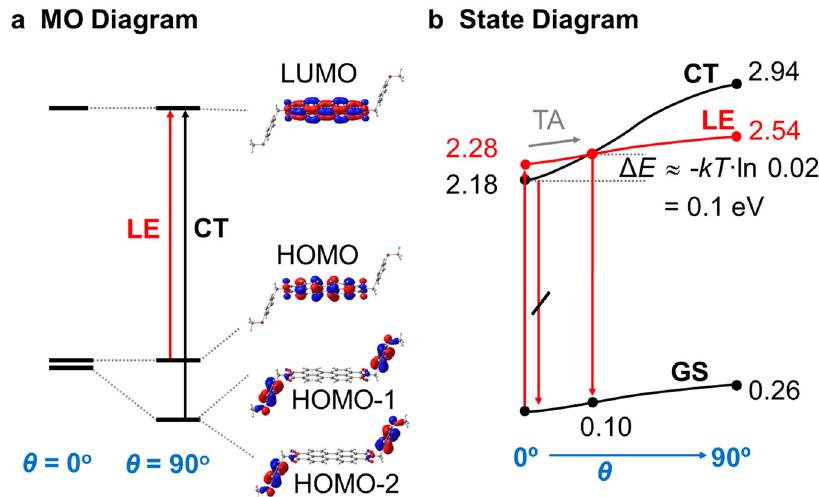
Fig. 4 | Deactivation model for the PBI derivatives in solution according to singlepoint TD-DFTcalculations. a FrontierMO energylevels andtopologies for torsional angle θ between the alkoxy and benzyl groups of 0° and 90°. b Potential